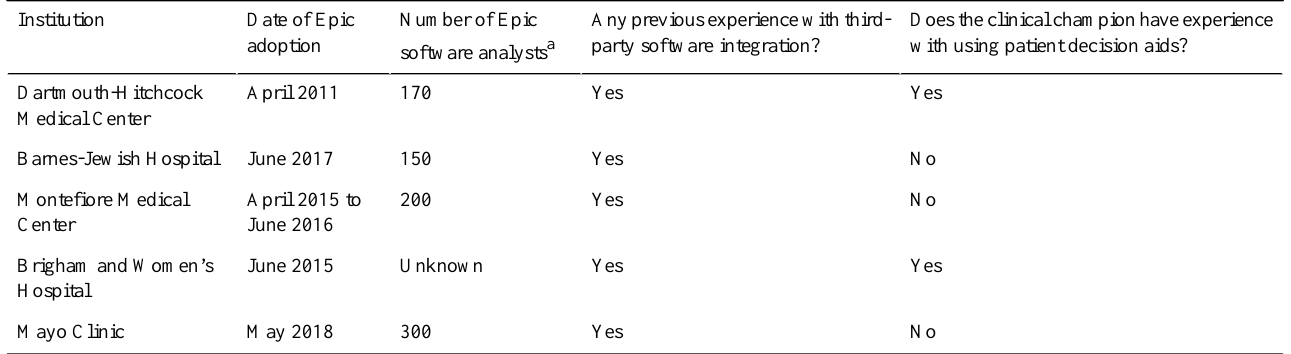
Table 1. Description of each institution’s Epic experience, expertise, and infrastructure.